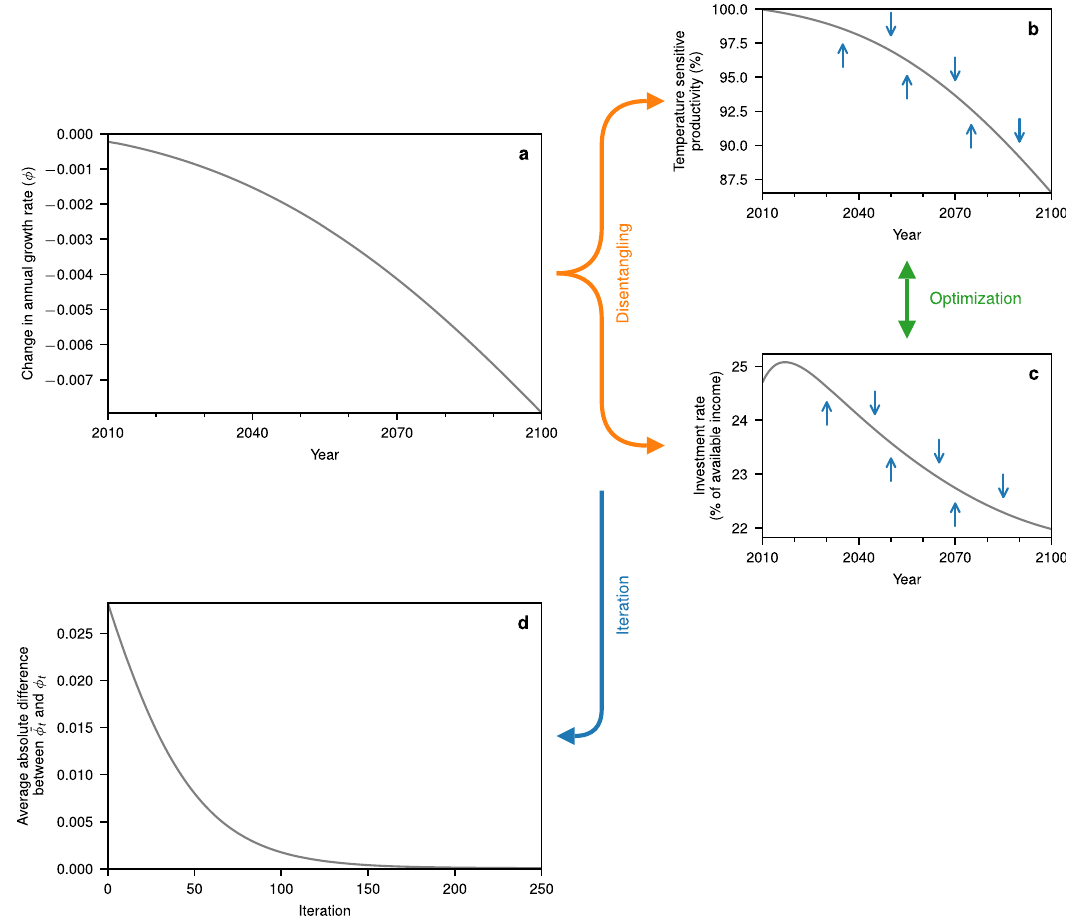
Fig. 2 Schematic representation of the iterative procedure. The estimated change in the annual growth rate due to temperature increase 9 ( a ) is disentangled into ( b ) the respective temperature-sensitive productivity function and into ( c ) its associated optimal investment response in the business-as- usual scenario, which is characterised by inaction of climate policy. d The iterated growth rate converges towards the estimated growth rate after ~200 iterations. Source data are provided as a Source Data fi le.